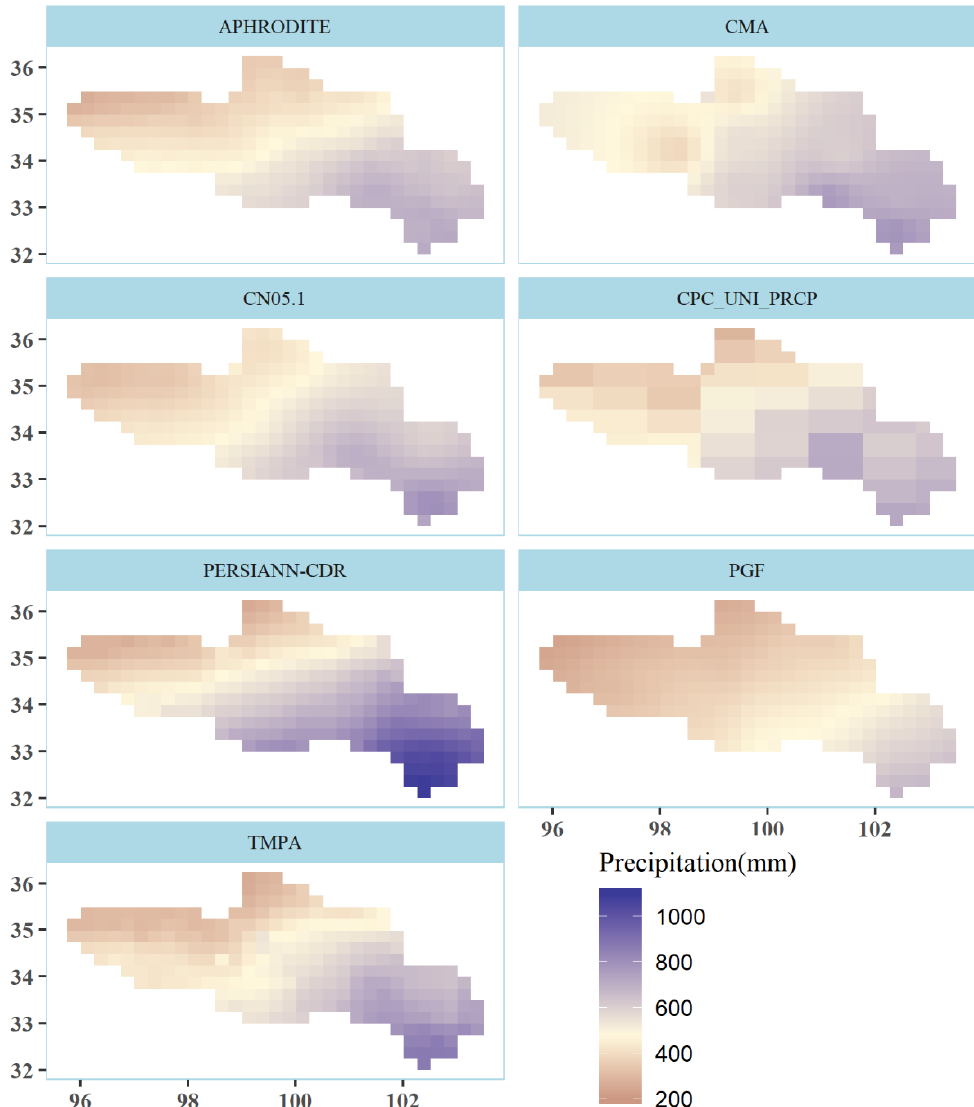
Figure 2. Spatial distribution of mean annual precipitation estimates (unit: mm) in the period 1998–2014 from the CMA gauge-based precipitation and 6 other SDFE or RA precipitation products.